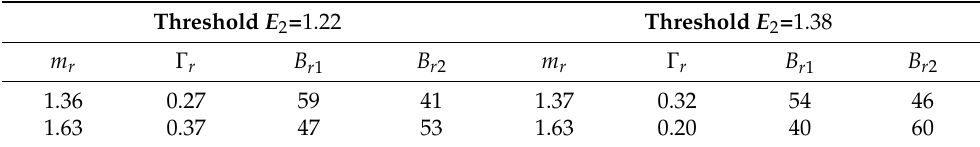
Table 2 contains the K-matrix parameters. The branching ratios are B ri = γ 2 Table 2. K-matrix parameters for two threshold positions.